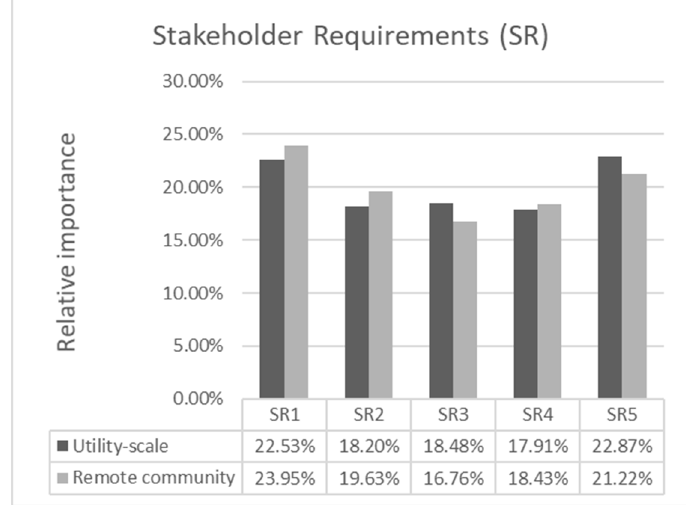
Figure 13. Relative importance of SR for the application market.